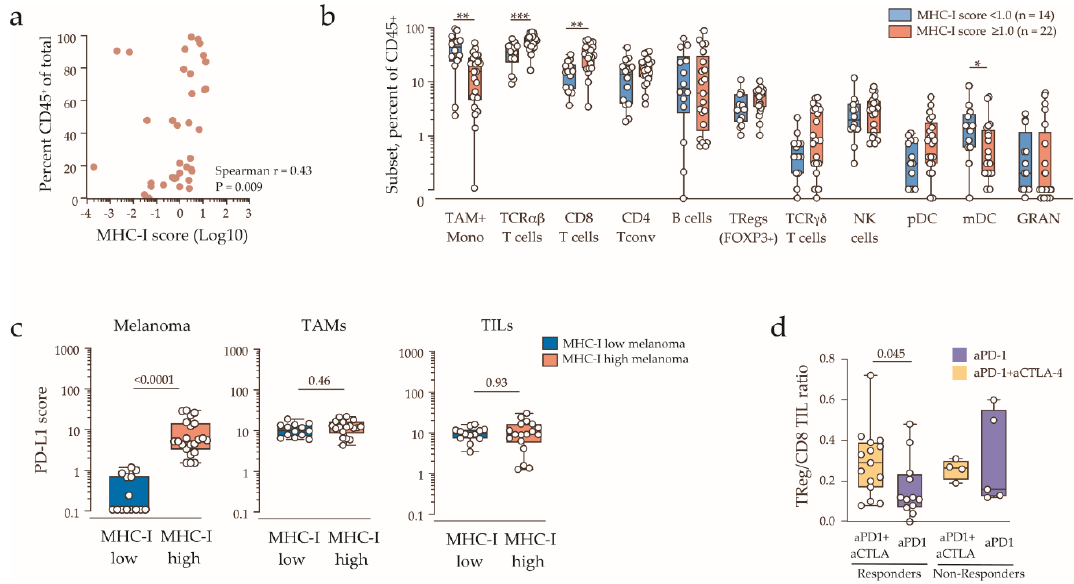
Figure 3 . Immune contexture stratified by tumor MHC-I expression. ( a ) Correlation of tumor immune infiltration (CD45 + fraction) and melanoma MHC-I expression score, with Spearman’s rank correlation coefficient and the p value indicated. ( b ) Immune contexture (percent of CD45 + fraction) of MHC-I normal / high (MHC-I score ≥ 1.0) and MHC-I low / negative tumors (MHC-I score < 1.0). Values below 0.1% are shown as zero. Boxes indicate the interquartile range and the median. Statistically significant comparisons (Mann-Whitney’s test) are indicated (* p < 0.05; ** p < 0.01; *** p < 0.001).